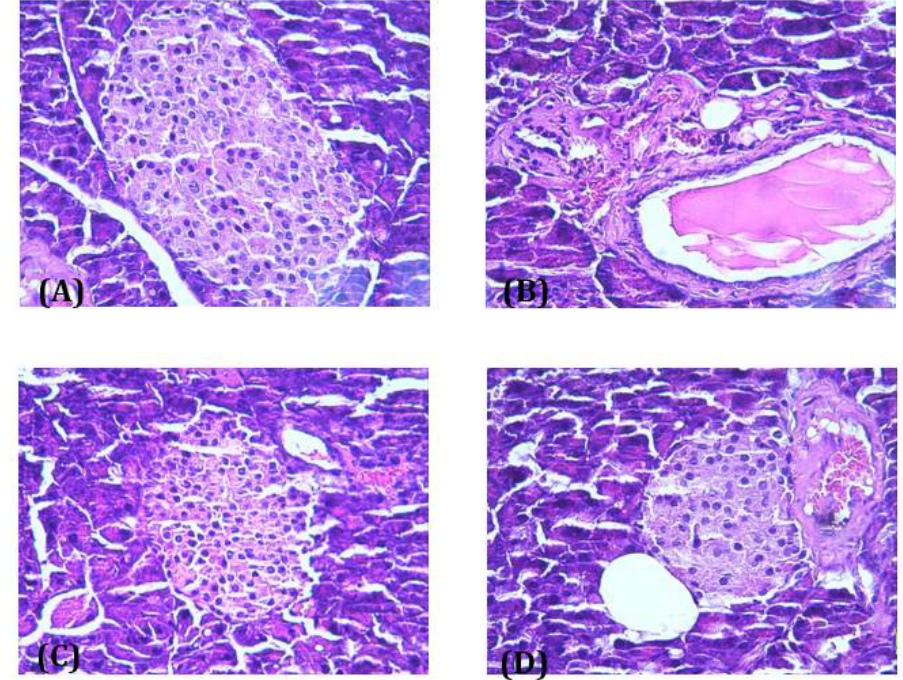
Figure 10. Histopathological observations of pancreatic islets of Langerhans of normal control ( A ), Allx group (100 mg/kg) ( B ), alloxan and EACe (60 mg/kg) ( C ), and Allx and Asc acid (40 mg/kg) ( D )(400× magnification).